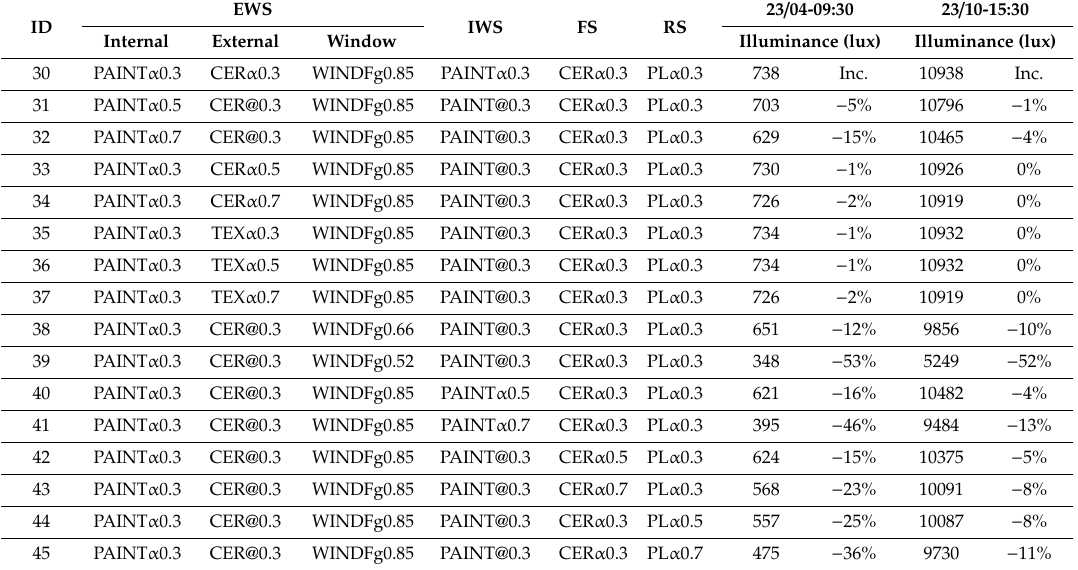
Table 21. Internal and external wall systems, floor systems, and roofing systems considered in numerical simulations and their results of luminous performance.